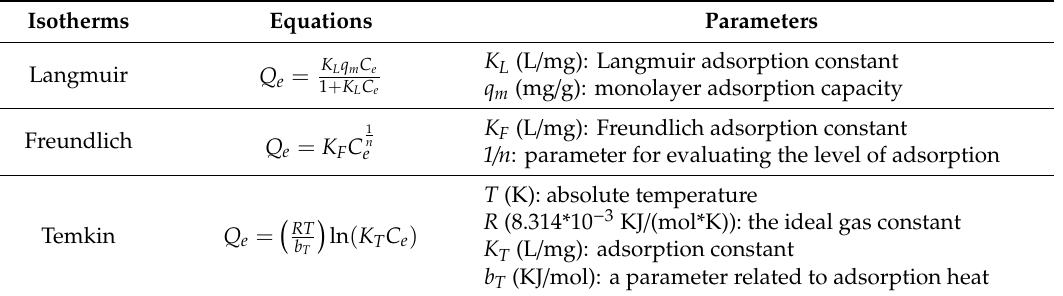
Table 3. The expression of the Langmuir, Freundlich, and Temkin isotherms. Isotherms Equations Parameters Langmuir